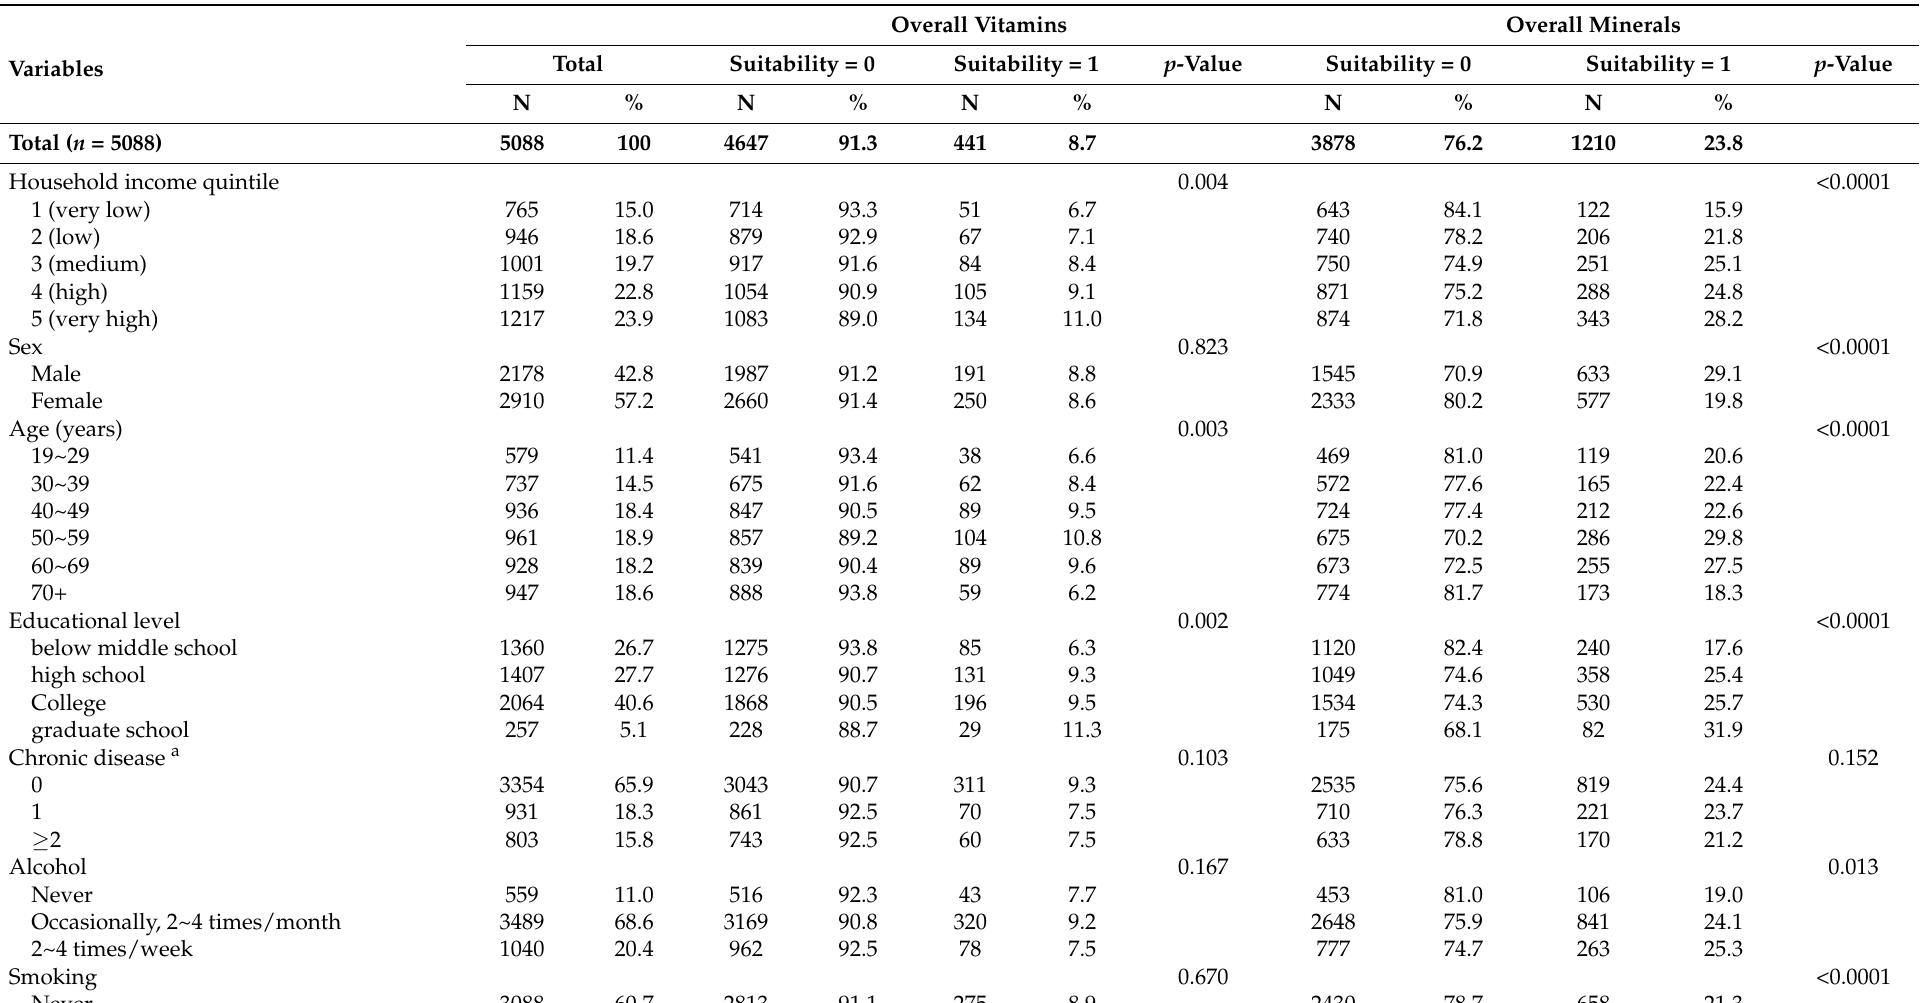
Table 1. General characteristics of study subjects according to overall vitamin, mineral intake. The number and percentage of participants from each group, and the p -values for each criterion, are shown. BMI: Body Mass